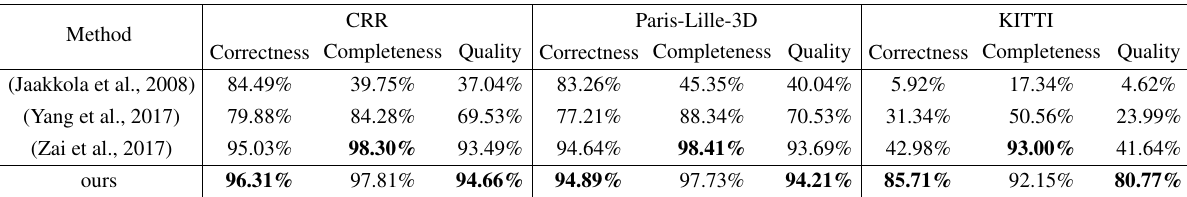
Table 3. Road boundary extraction results on CRR, Paris-Lille-3D and KITTI dataset, respectively. Our method achieves best completeness and quality on all dataset compared with other competitive methods. Especially, our method has a prominent improvement on the low accuracy LiDAR dataset (KITTI).